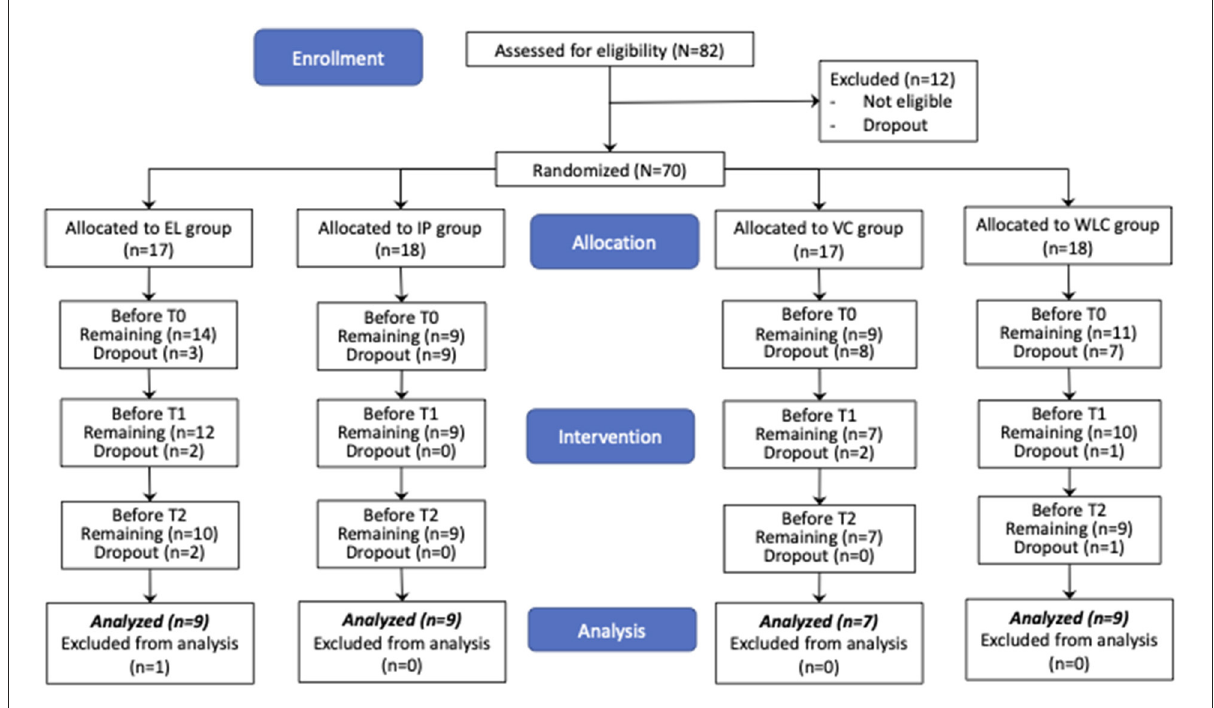
FIGURE1 CONSORT 2010 flow chart for participant recruitment &